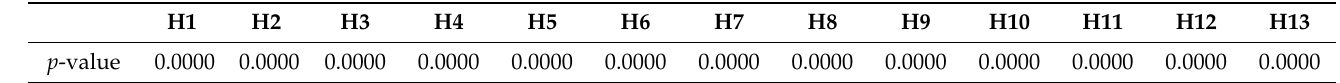
Table 7. Statistical comparison of Haralik texture features of hand-annotated RTS samples from Eureka Sound Lowlands and Banks Island using independent Wilcoxson test. ( n =